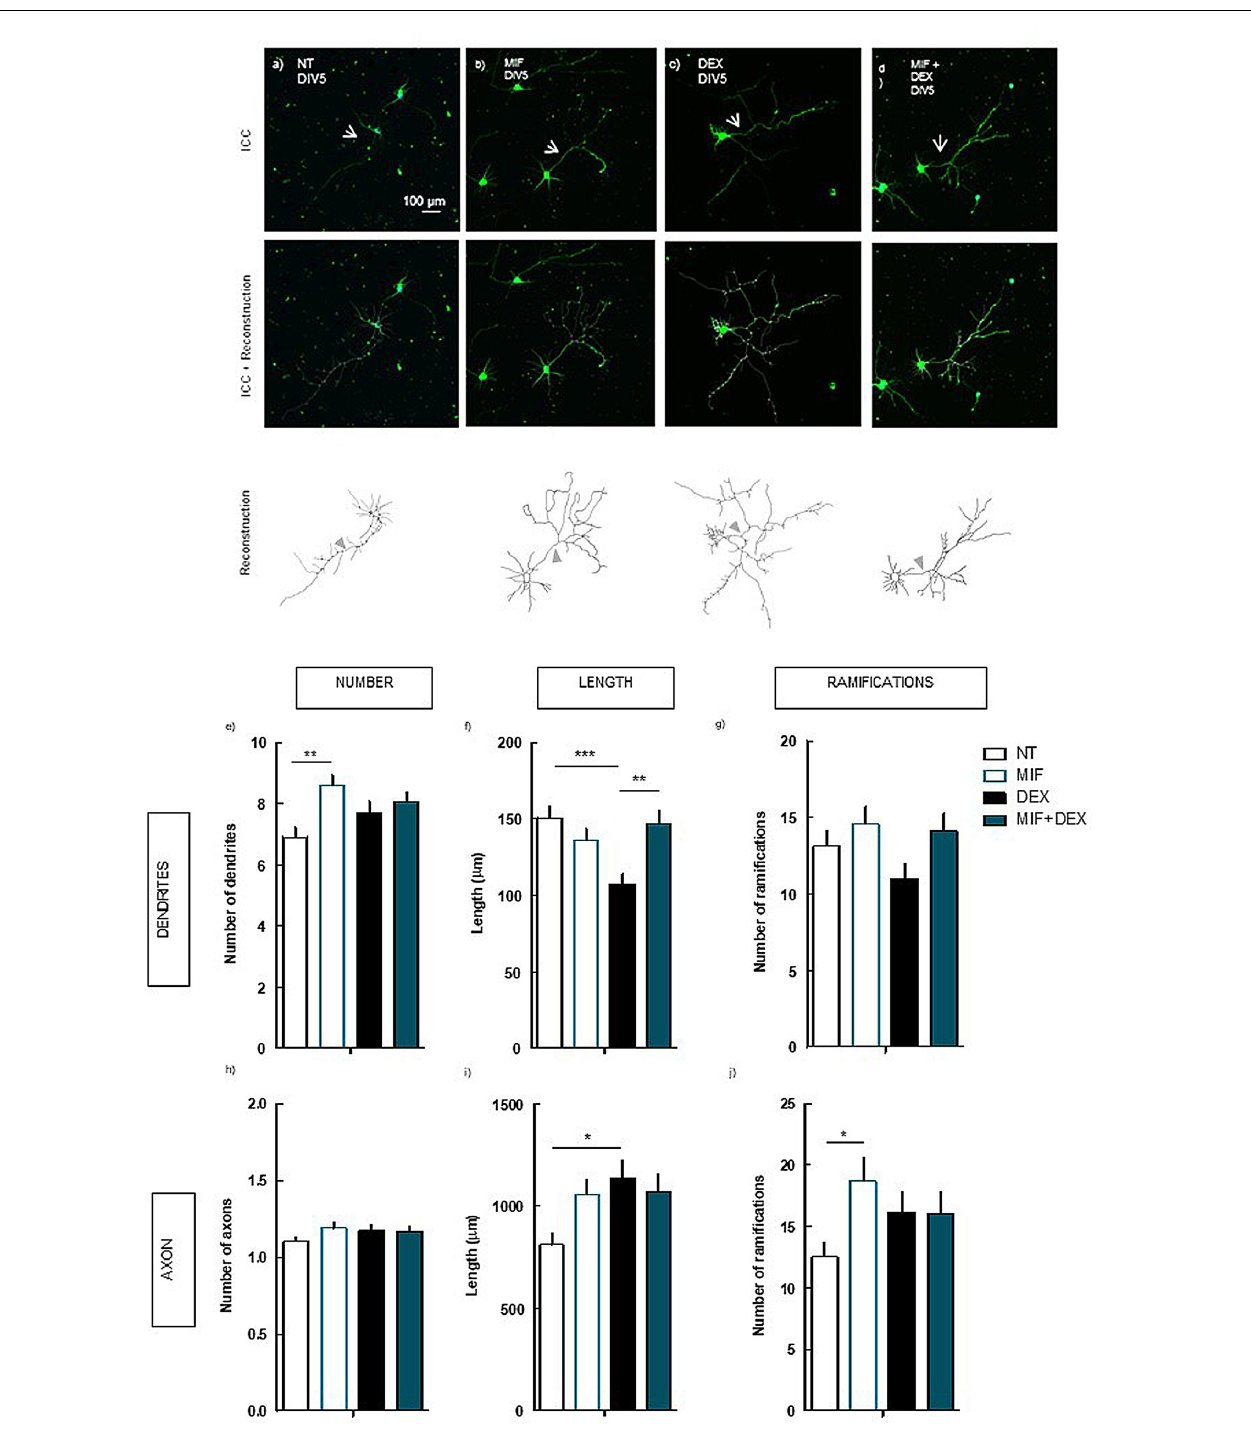
FIGURE 4 | Effect of the blockade of GR per se and on DEX exposure (4 days treatment) in hippocampal neurons (DIV5). Hippocampal neurons from ED18 rats were cultured in vitro for 5 days (DIV5). Cultured neurons were treated with the GR antagonist, MIF (1 µ M), or with the GR antagonist and/or DEX (250 nM; at 24 h in culture). Neuronal morphology was assessed by manual reconstruction in Neurolucida software (a–d) and morphometric data were acquired in Neurolucida Explorer, regarding the number (e) , length (f) , and number of ramifications (g) of dendrites and the number (h) , length (i) , and number of ramifications (j) of axons (identified with an arrow in the representative images). Results are expressed as mean ± SEM of 120 cells, from five independent experiments. Statistical significance was assessed by one-way ANOVA followed by Tukey’s Multiple Comparison Test: ∗ p < 0.05, ∗∗ p < 0.01, ∗∗∗ p < 0.001, as indicated by the horizontal lines above the columns. ICC, immunocytochemistry; NT, non-treated; MIF, mifepristone, GR antagonist.; DEX, dexamethasone; MIF+DEX, mifepristone + dexamethasone.